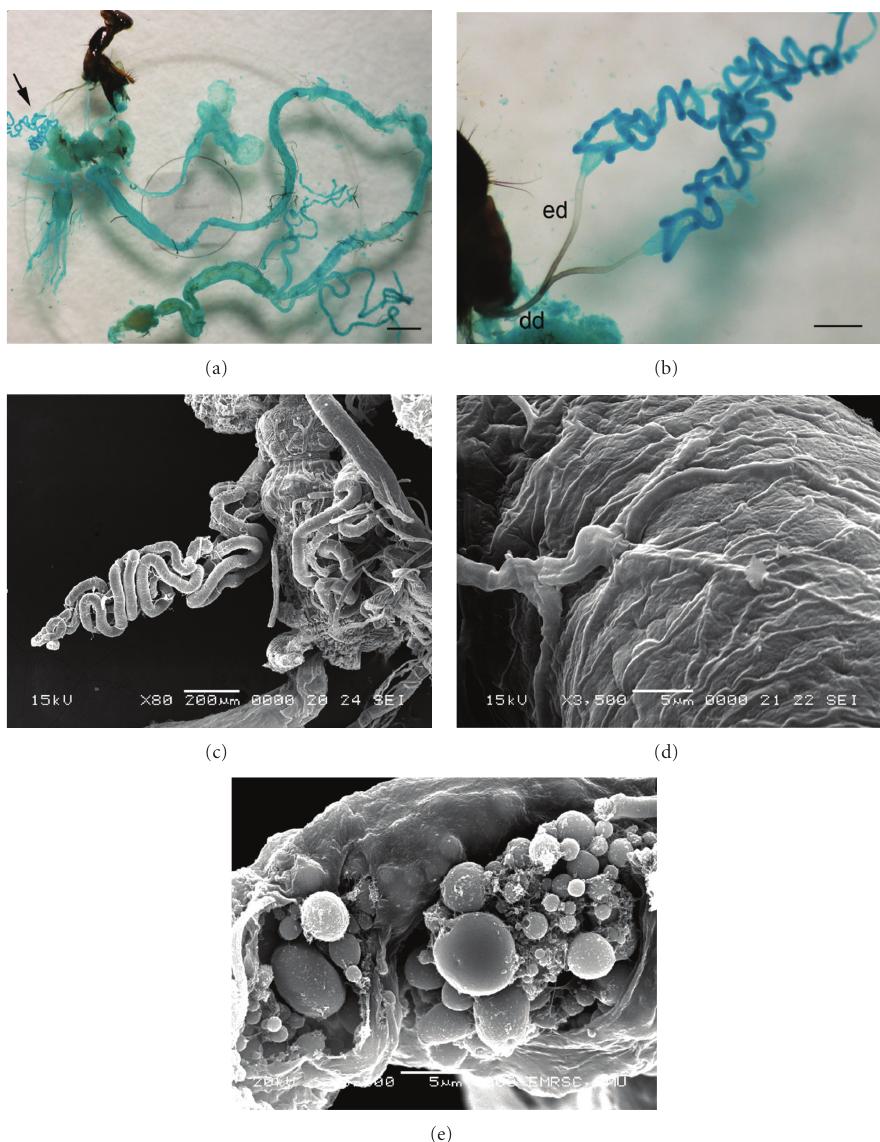
Figure 1: Micrographs of the salivary gland in adult male C. megacephala . (a) Light micrograph of the whole excised alimentary canal showing salivary glands (arrow) situated in the foregut region. Bar = 10 µ m. (b) Light micrograph indicating a translucent single median deferent duct (dd) bifurcated into two long, narrow e ff erent ducts (ed) connected to the coiled tubular glands. Bar = 5 µ m. (c–e; SEM micrographs) (c) Coil salivary gland at one side. (d) Intense tracheal ramification onto the gland surface. (e) Ruptured gland exhibiting numerous rounded vesicles that are probably secretory